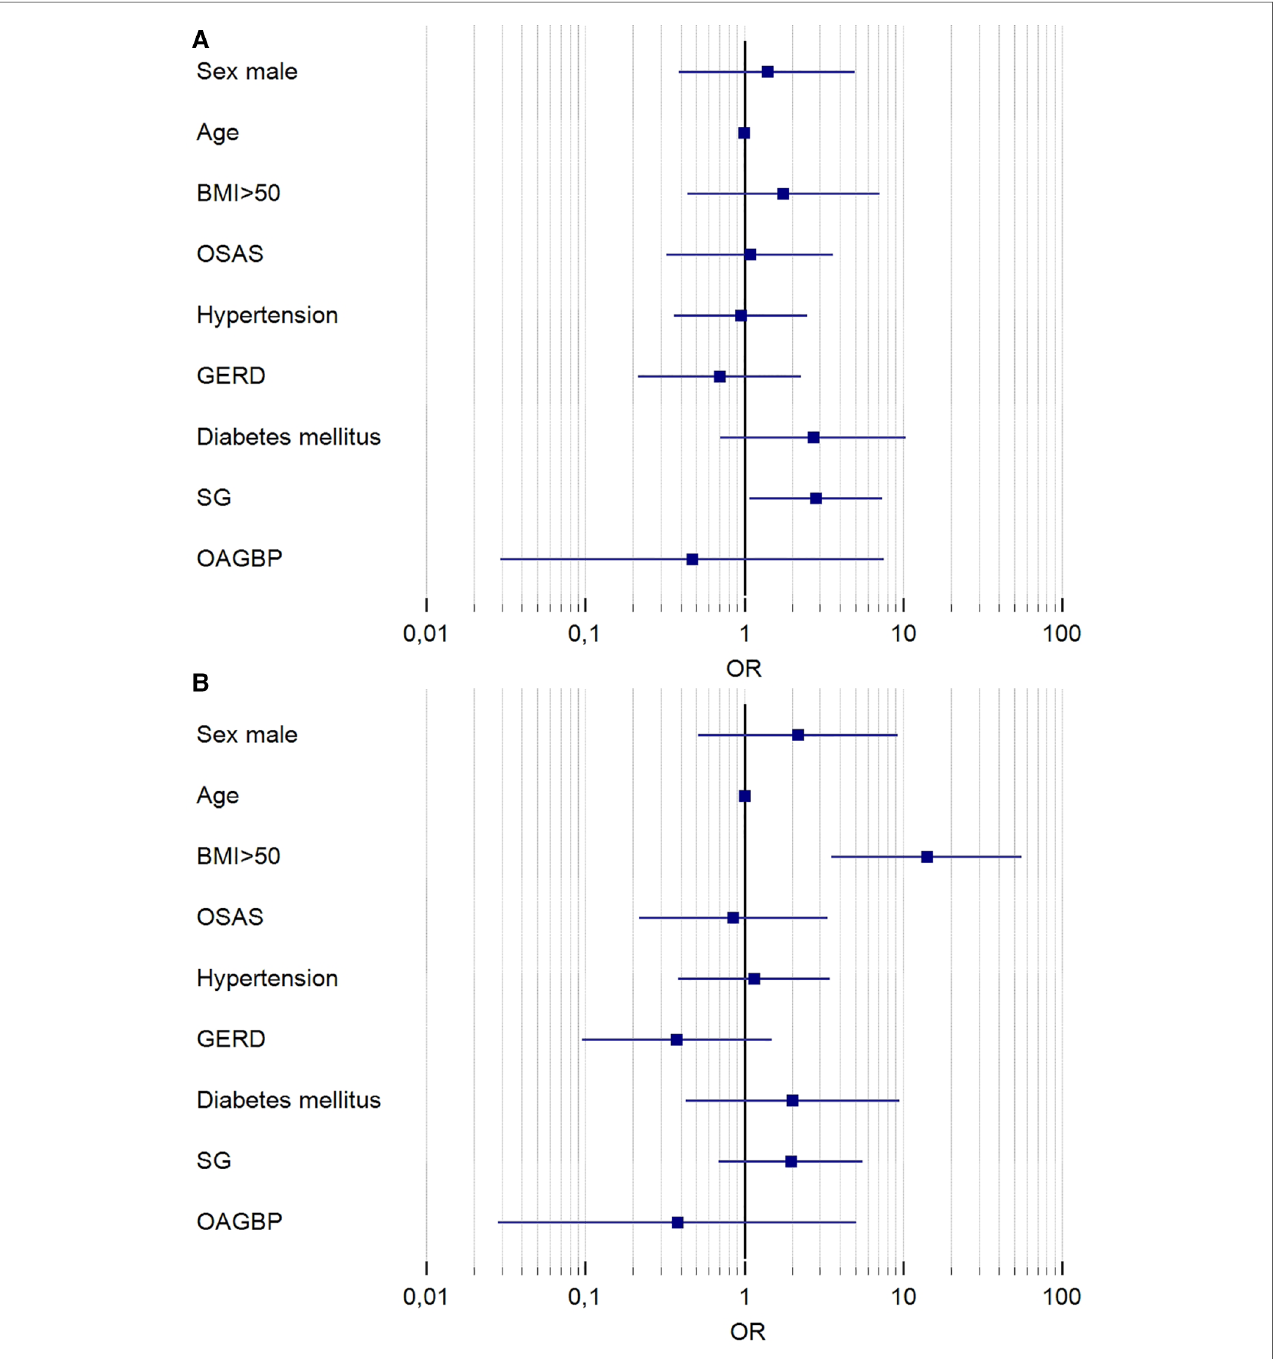
FIGURE 2 Forest plot of results of multivariate analysis. Results are reported in logarithmic scale. In ( A ) are reported the results of logistic regression considering the outcome of EWL>50% at 24 months; the only signi fi cant variable predictive of surgical failure was SG (OR=2.816; 95%CI=1.0741 – 7.3837; p =0.0353). In ( B ) are reported the results of logistic regression considering the outcome of BMI<35 Kg/m 2 at 24 months. The only signi fi cant variable predictive of surgical failure was superobesity (OR=14.04; 95%CI=3.5443 – 55.6861 p =0.002). OR, odds ratio; OSAS, obstructive sleep apnea syndrome; GERD, gastroesophageal re fl ux disease; SG, sleeve gastrectomy; OAGBP, one-anastomosis gastric